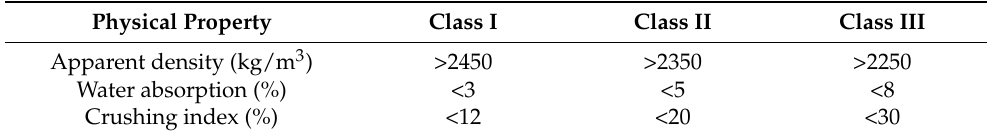
Figure 6. Physical properties of RCA: ( a ) apparent density; ( b ) water absorption; ( c ) crushing index; and ( d ) slump. Table 3. Physical performance grade of RCA.